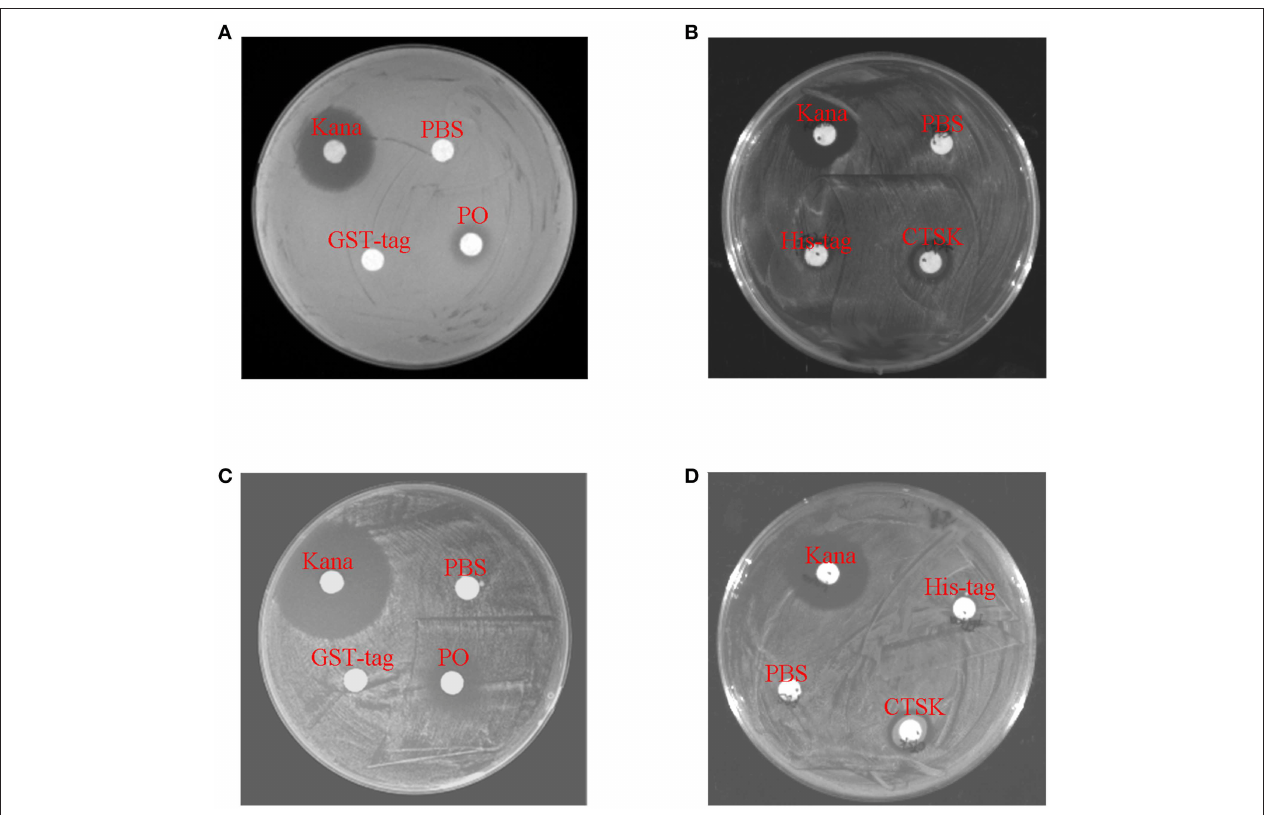
FIGURE 7 | Antibacterial activities of rMpPO and rMpCTSK evaluated by the bacterial inhibition loop method. (A,B) The growth of V. parahaemolyticus on an LB agar plate with rMpPO or rMpCTSK added. (C,D) The growth of Staphylococcus aureus on an LB agar plate with rMpPO or rMpCTSK added. Kanamycin was used as positive control. GST-tagged protein/His-tagged protein and PBS were used as negative